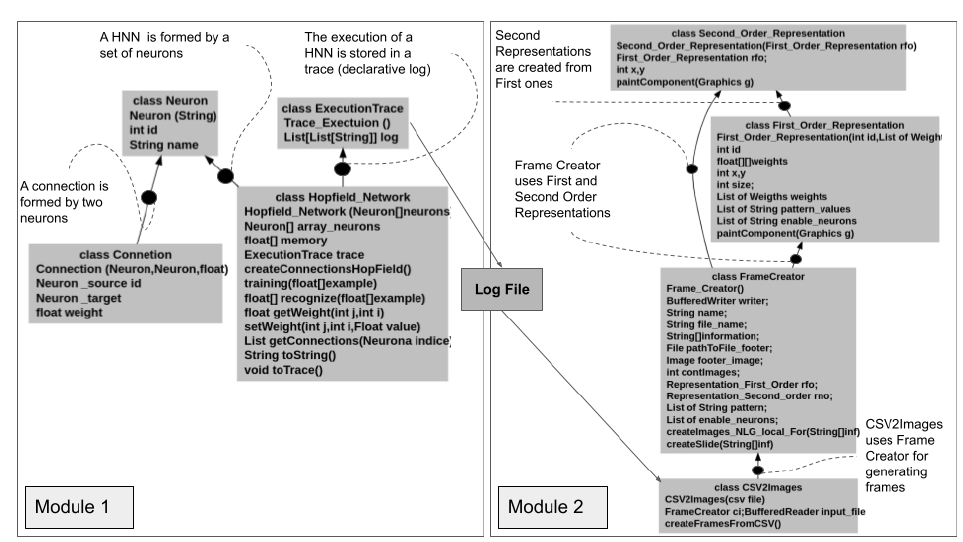
Figure 9. Modules and their diagrams of classes (main elements, attributes and methods for each